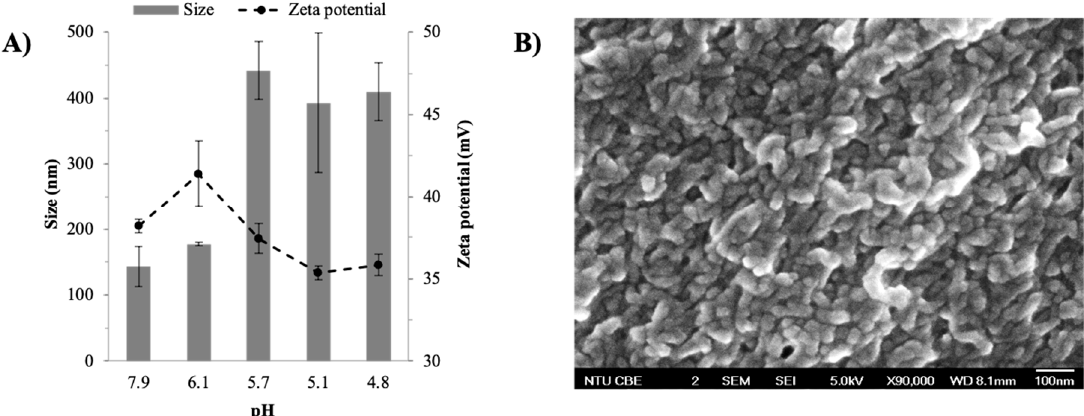
Figure 2. ( A ) Effect of pH on size, zeta potential as measured by dynamic light scattering microscopy (DLS); ( B ) FESEM image of the QUE–CHI nanoplex.